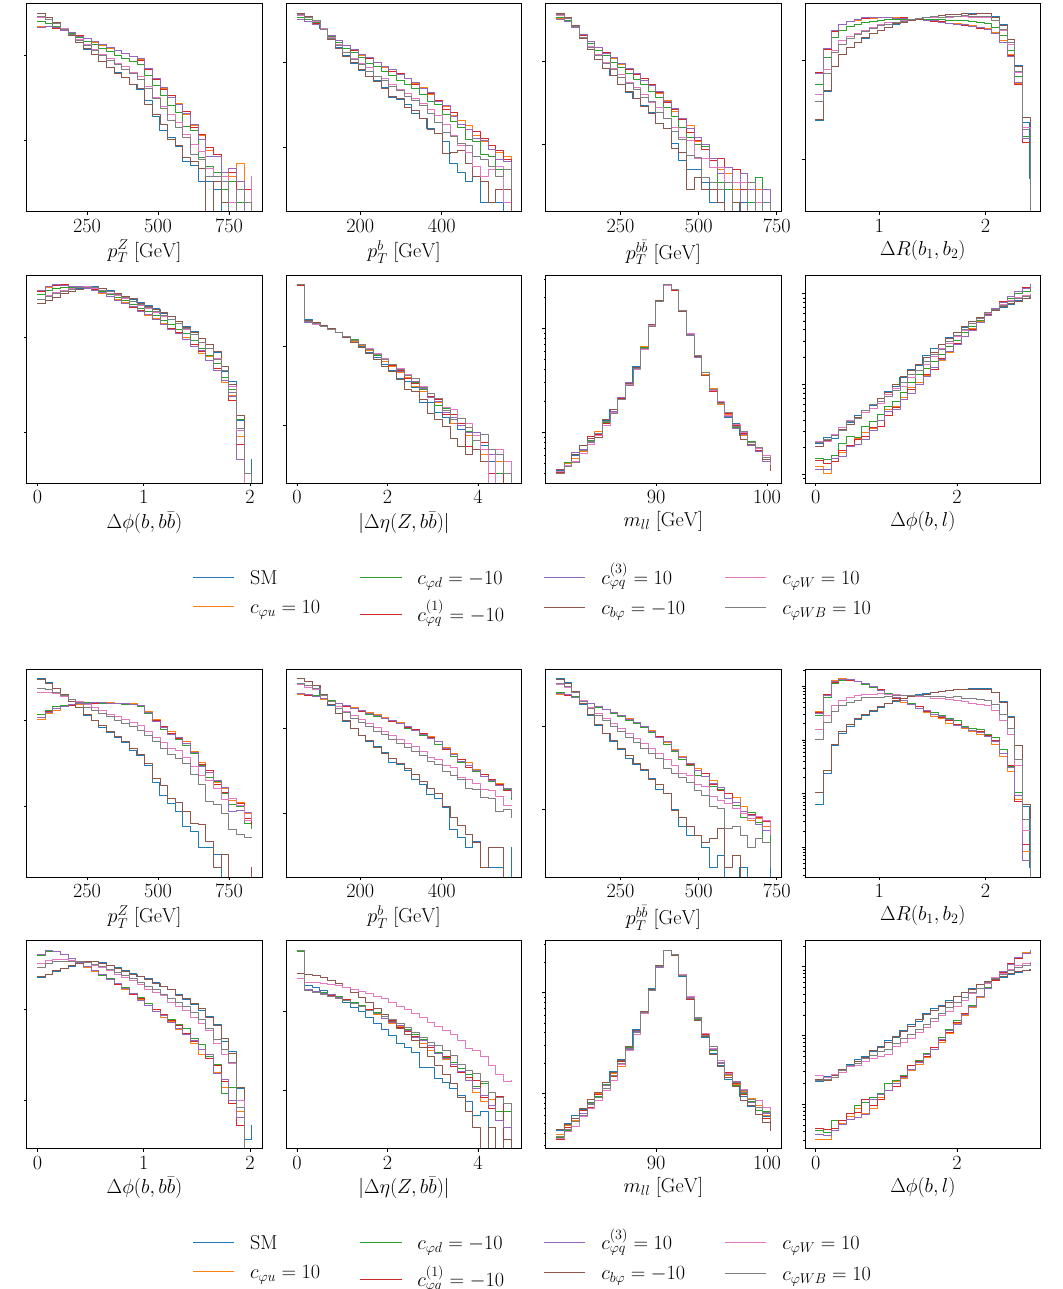
Figure 7. Differential distributions in the kinematic features used to parametrize the likelihood ratio in the hZ → b ¯ b‘ + ‘ − process. We compare the SM predictions with those obtained in the SMEFT when individual operators are activated for coefficient values used for the neural network training. Results are shown separately at the linear-only level (upper) and quadratic-only (bottom panels) level and normalized to their fiducial